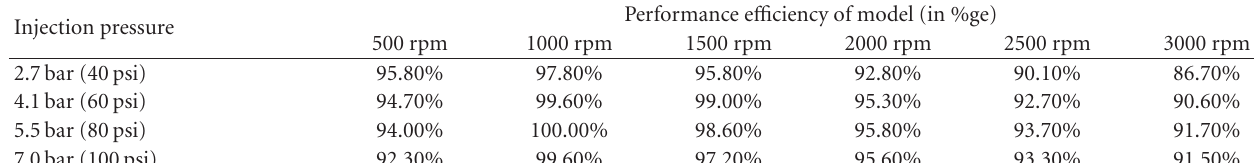
Table 3: Actual performance versus speed of rotation.